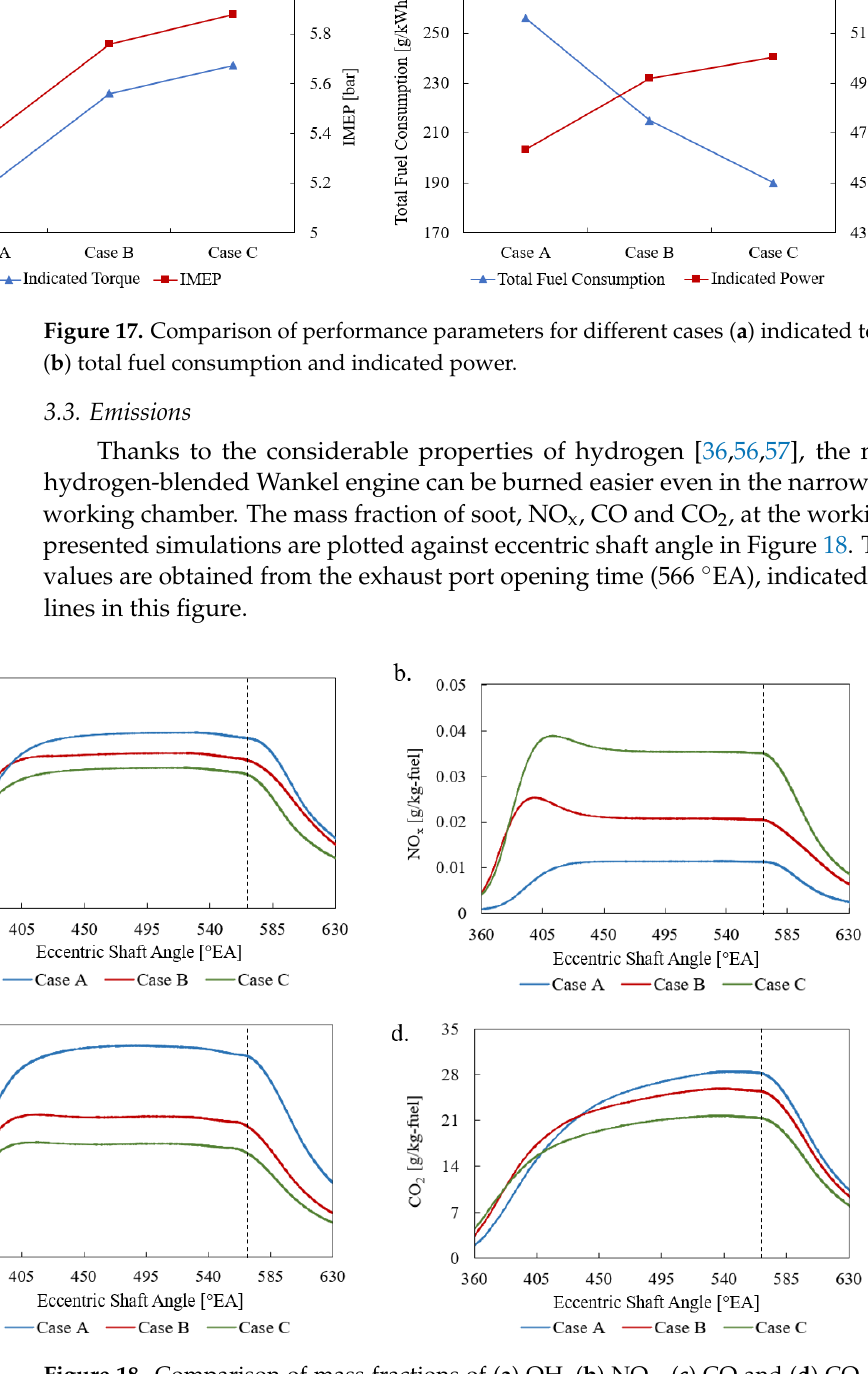
Figure 18. Comparison of mass fractions of ( a ) OH, ( b ) NO x , ( c ) CO and ( d ) CO 2 at the working chamber for different cases.